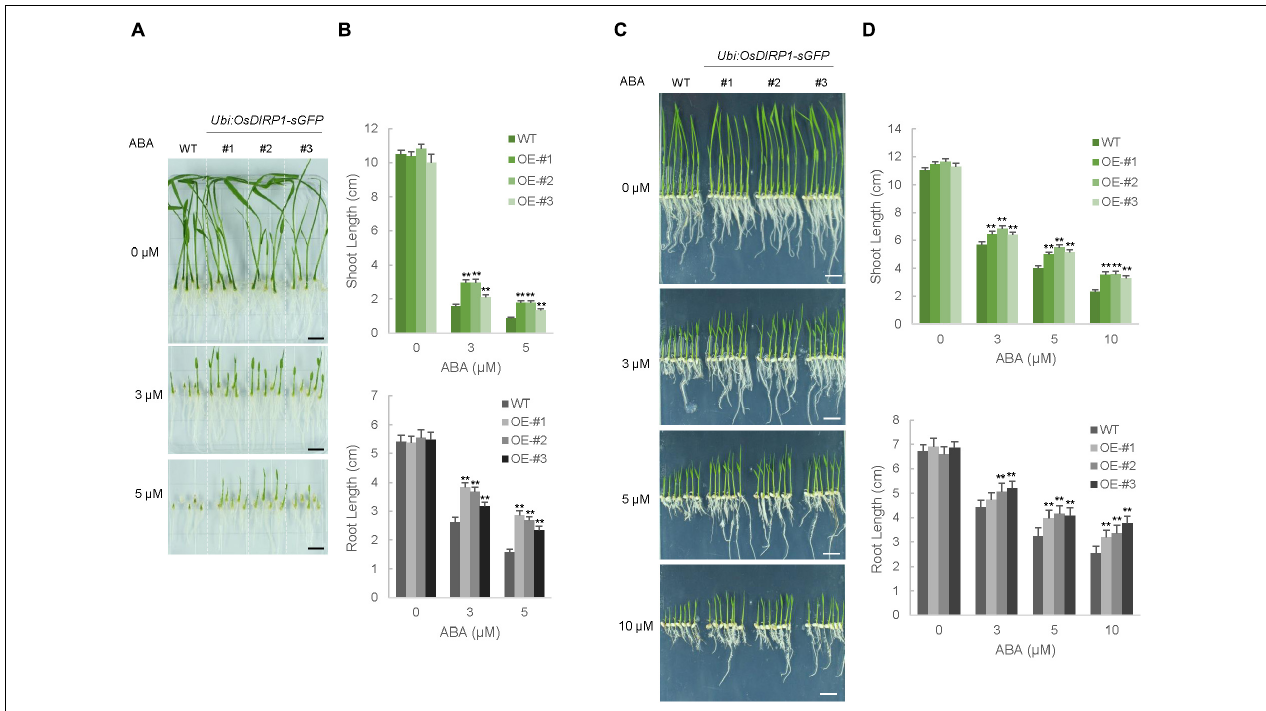
FIGURE 5 | Hyposensitive phenotypes of Ubi:OsDIRP1-sGFP transgenic rice plants in response to ABA. (A) Germination tests of wild-type and T4 Ubi:OsDIRP1-sGFP (lines #1, #2, and #3) transgenic seeds in response to ABA. Sterilized seeds were germinated on half-strength MS medium in the presence of different concentrations (0, 3, and 5 µ M) of ABA. Representative photos were taken at 7 days after germination. (B) Diagram of shoot and root lengths in the germination assays. The shoot and root lengths were measured at 7 days after germination. Data are means ± SE ( n ≥ 3 biological independent experiments; > 50 plants were used in each assay, ∗∗ P < 0.01, Student’s t -test). (C) Post-germination assays. Wild-type and T4 Ubi:OsDIRP1-sGFP (lines #1, #2, and #3) seeds were germinated on half-strength MS medium for 2 days, after which germinated seedlings were transferred to half-strength MS medium supplemented with 0, 3, 5, and 10 µ M ABA. Representative photos were taken at 6 days after transfer. (D) Diagram of the shoot and root lengths in the post-germination assays. Data are means ± SE ( n ≥ 3 independent experiments; > 100 plants were used in each assay, ∗∗ P < 0.01, Student’s t